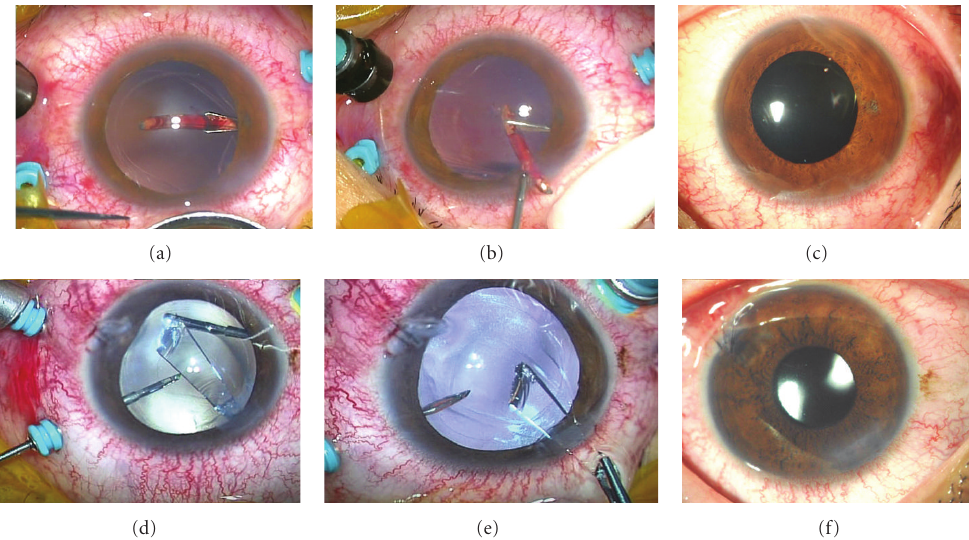
Figure 2: Intraoperative photographs and postoperative slit-lamp photographs of Case 1 (a, b, c) and Case 2 (d, e, f). (a) and (b) Metallic foreign body extracted through an anterior and posterior capsulorhexis, and corneal incision (triple C-through technique). (c) Slit-lamp photograph (inverted image as seen by the surgeon) 1 day postoperatively showing no need of suturing, no subconjunctival haemorrhage, and well-positioned intraocular lens. (d) and (e) Glass foreign body extracted through an anterior and posterior capsulorhexis, and corneal incision (triple C-through technique). (f) Slit-lamp photograph (inverted image as seen by the surgeon) 1 day postoperatively showing no need of suturing, except the original penetration wound, no subconjunctival haemorrhage and well-positioned intraocular